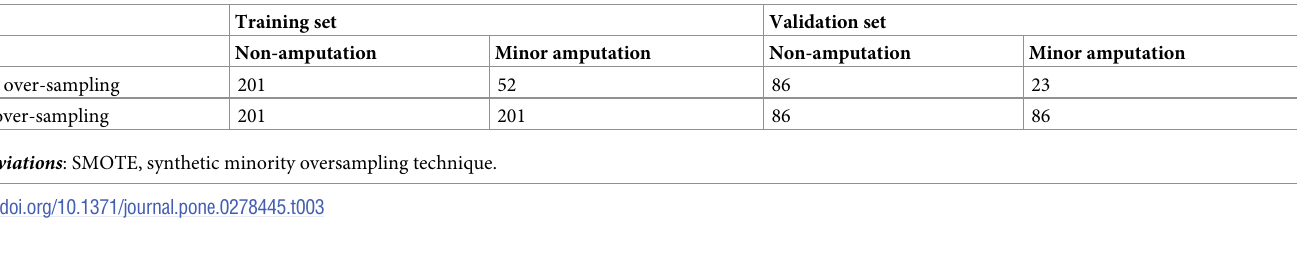
Table 3. Data distribution of both the training set and validation set before and after